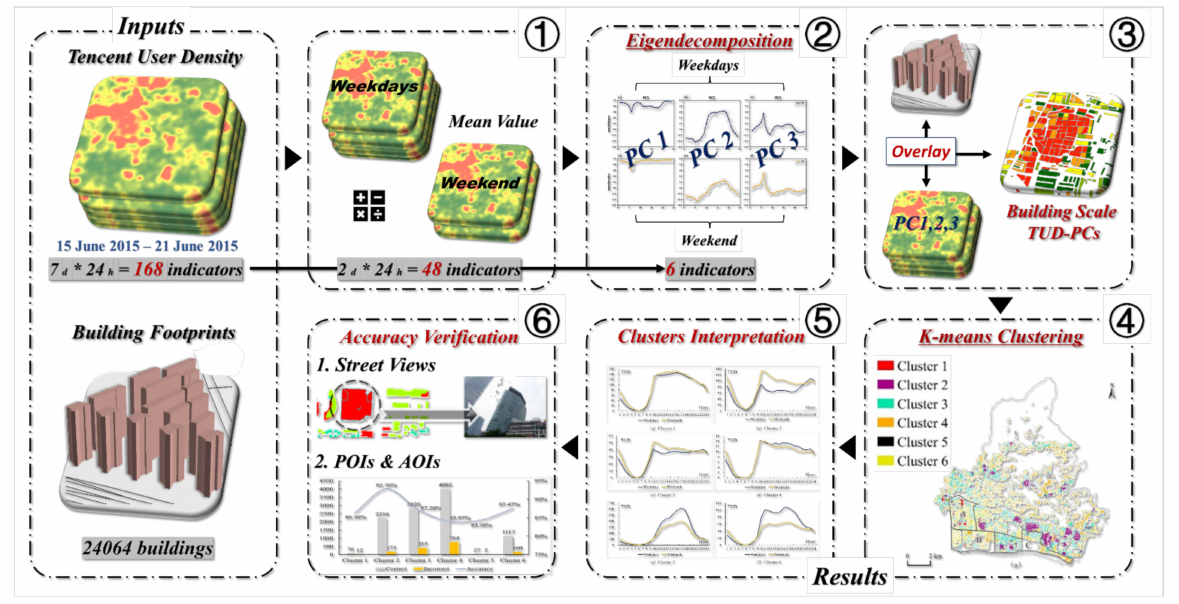
Figure 2. Workflow of the